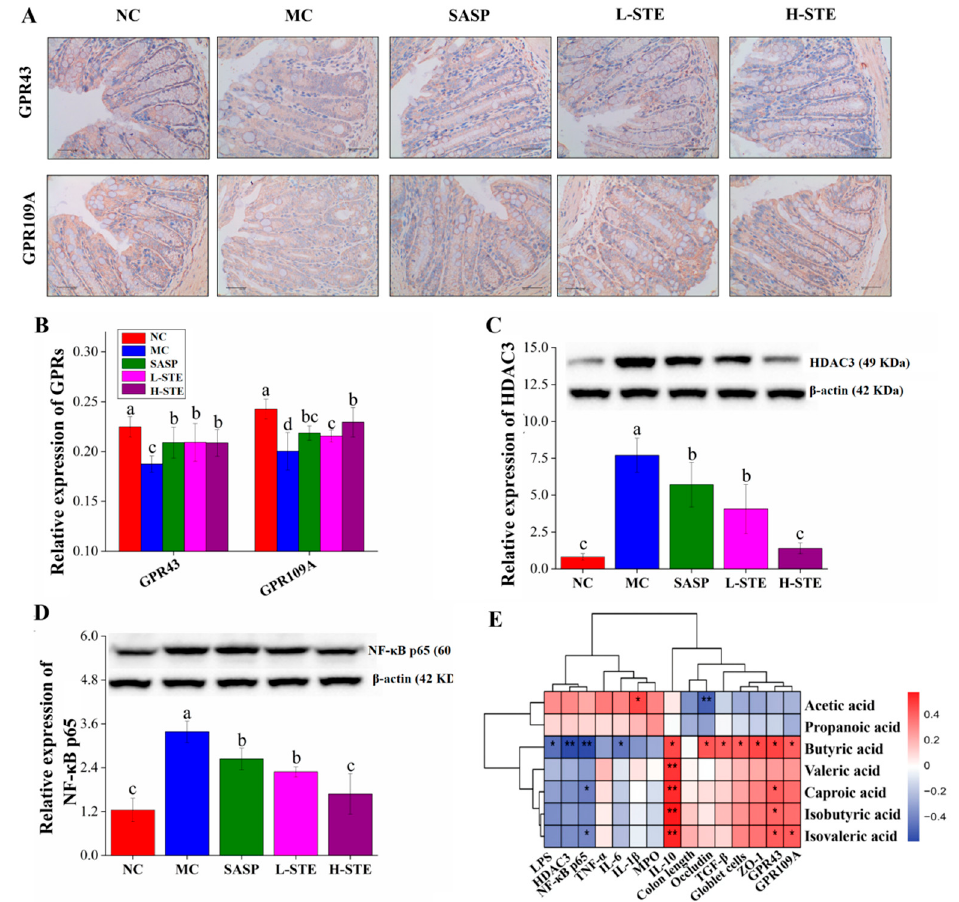
Figure 5. Effects of STE on the expression of GPRs, HDAC3, and NF- κ B p65 in the colon of DSS- induced ulcerative colitis mice. ( A ) The immunohistochemistry analysis of GPR43 and GPR109A in the colon (magnification of 400×). ( B ) The expression of GPR43 and GPR109A in the colon. ( C ) The expression of HDAC3 protein in the colon. ( D ) The expression of NF- κ B p65 protein in the colon. ( E ) Correlation between SCFAs and indicators of intestinal barrier and inflammatory indexes (* p < 0.05, and ** p < 0.01). Values are expressed as the mean ± the SD ( n = 5). Bars with different lowercase letters indicate significant differences ( p < 0.05).